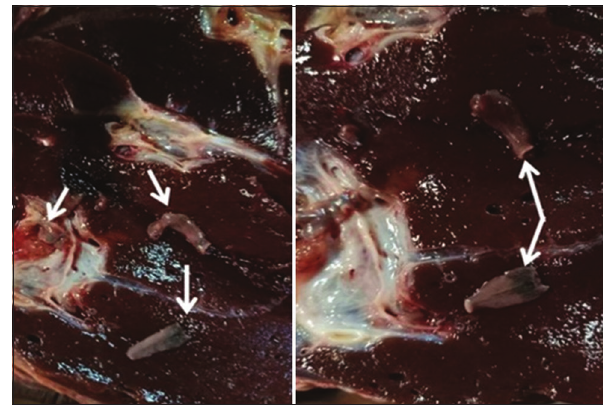
Figure-1: Live photo of whole worm of Fasciola spp., in bile duct in sacrificed